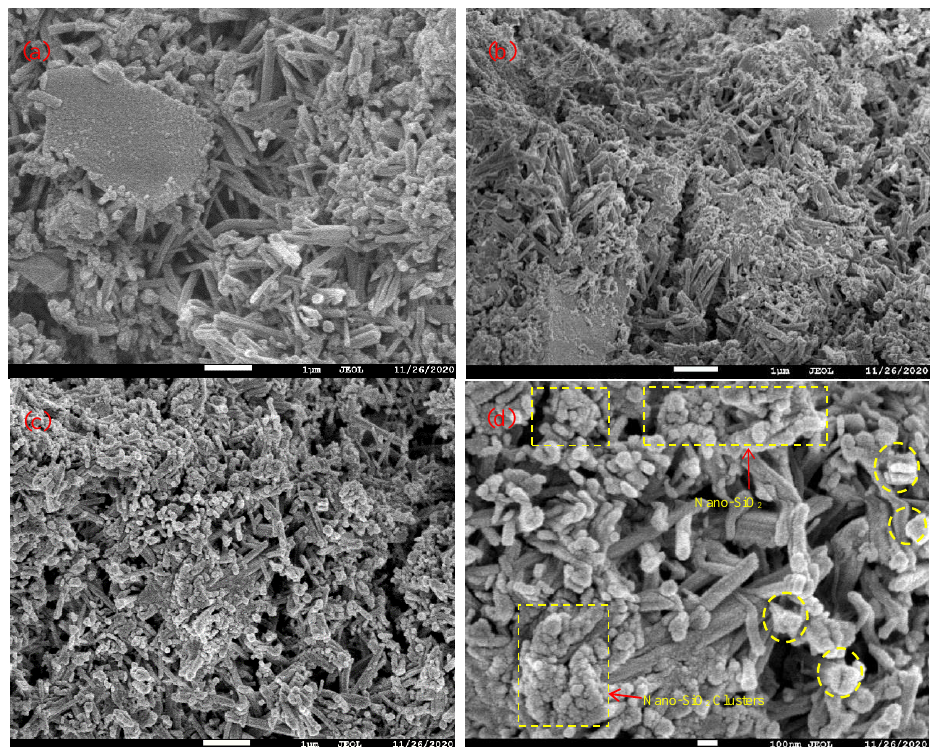
Figure 7. SEM micromorphology of the HBSAC cement hydration products with different con- tents of nanosilica sol: ( a ) nanosilica sol content 2% at 1 day; ( b ) nanosilica sol content 0 at 1 day; ( c ) nanosilica sol content 2% at 28 days; ( d ) nanosilica sol content 2% at 28 days.